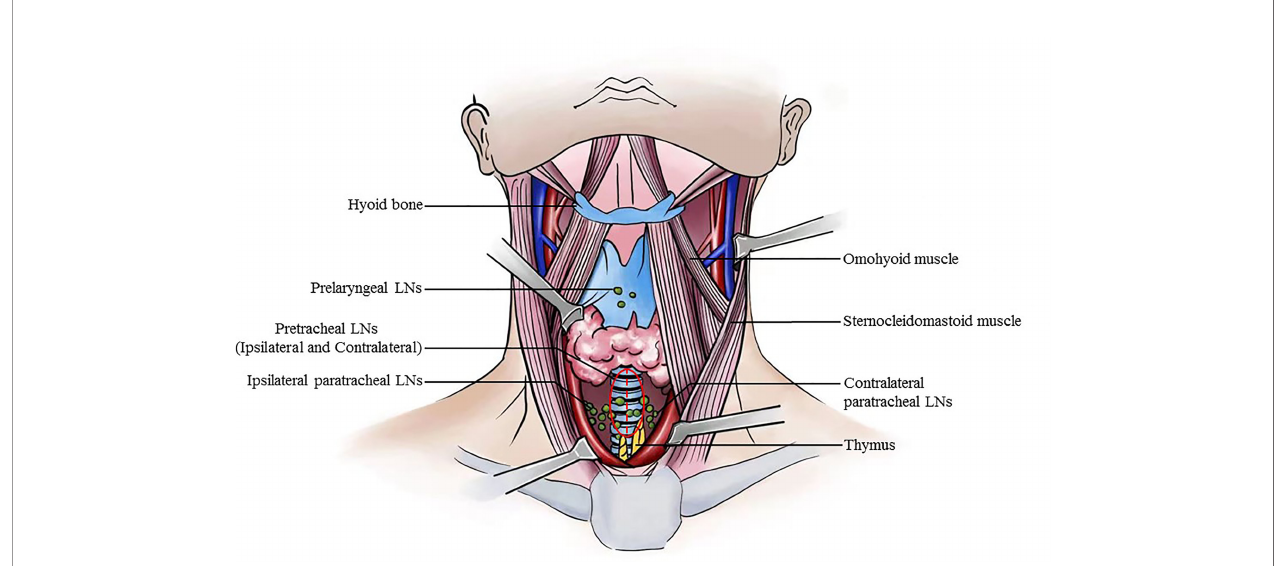
FIGURE 1 | Illustration of pretracheal lymph node subdivision in the central